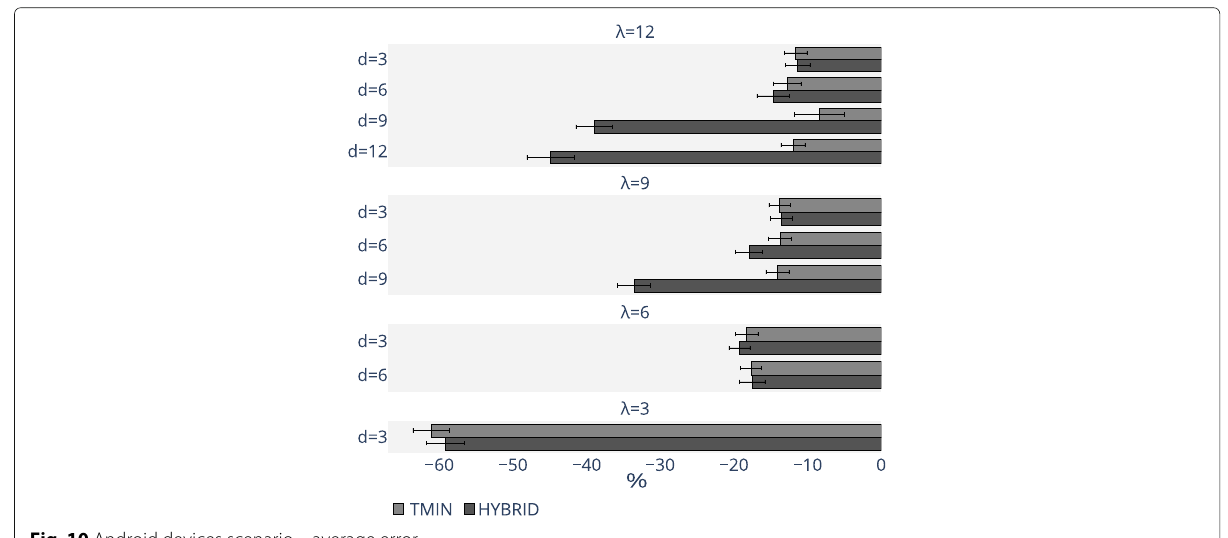
Fig. 10 Android devices scenario – average